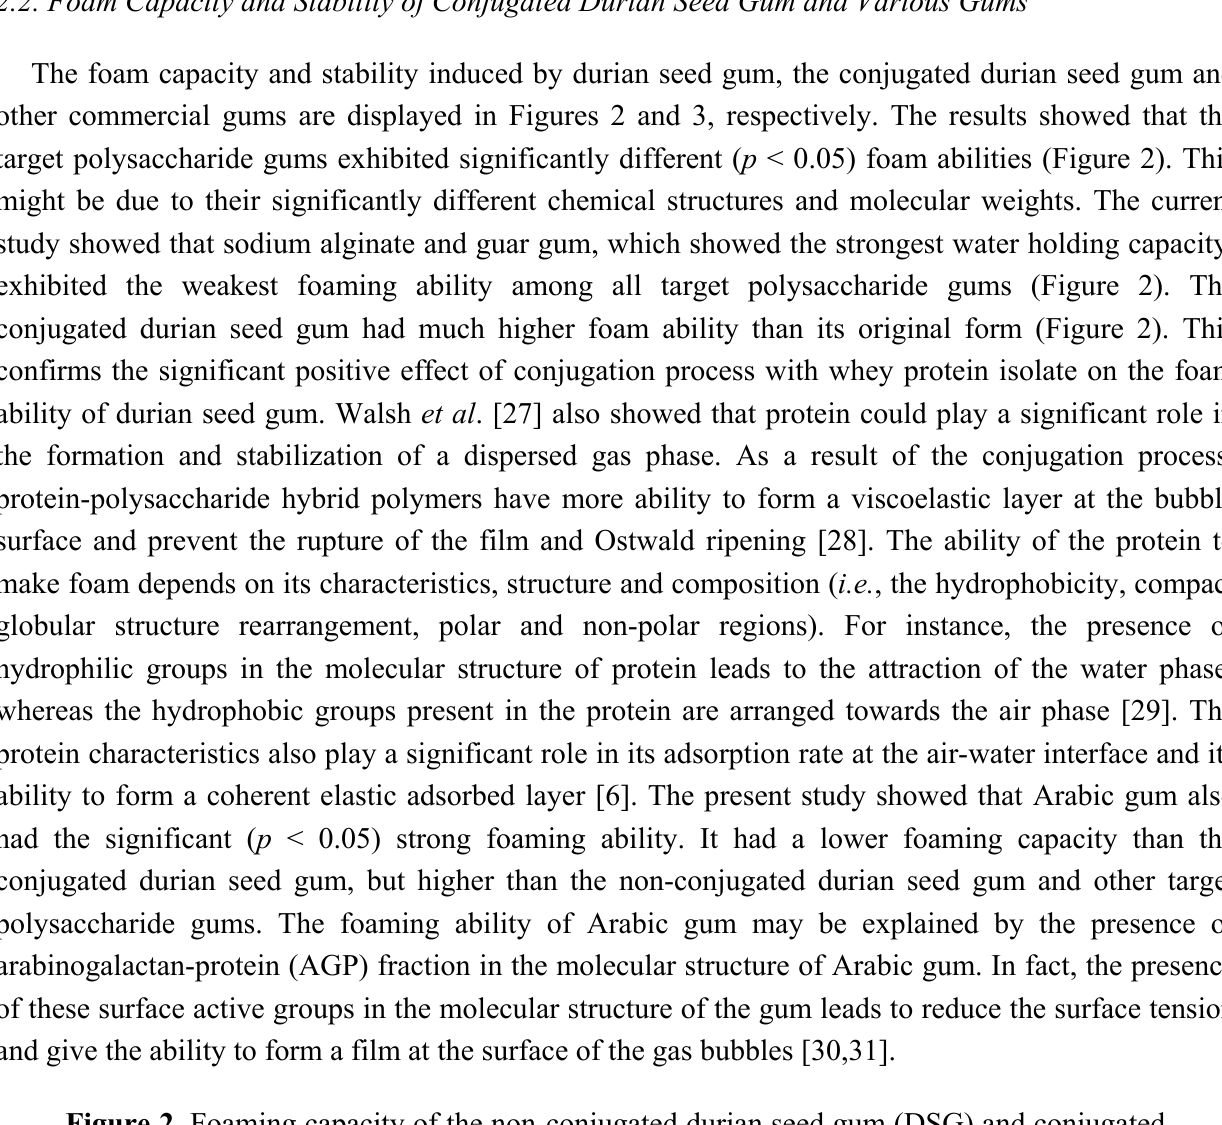
Figure 2. Foaming capacity of the non-conjugated durian seed gum (DSG) and conjugated durian seed gum (DSG-WPI) as compared to other commercial gums ( i.e. , Arabic gum (AG), sodium alginate (SA), kappa carrageenan (KC), guar gum (GG), and pectin (P); a – f : significant different at p <